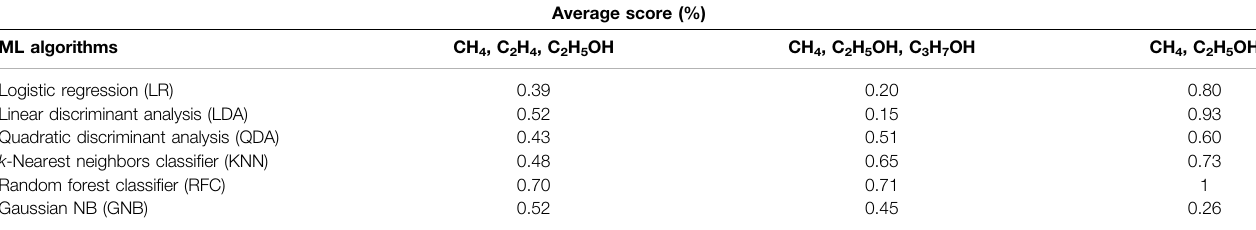
TABLE 3 | The results of cross-validation with six different classi fi cation algorithms against the type of products in three classes [a group of (CH 4 , C 2 H 4 , C 2 H 5 OH) (CH 4 , C